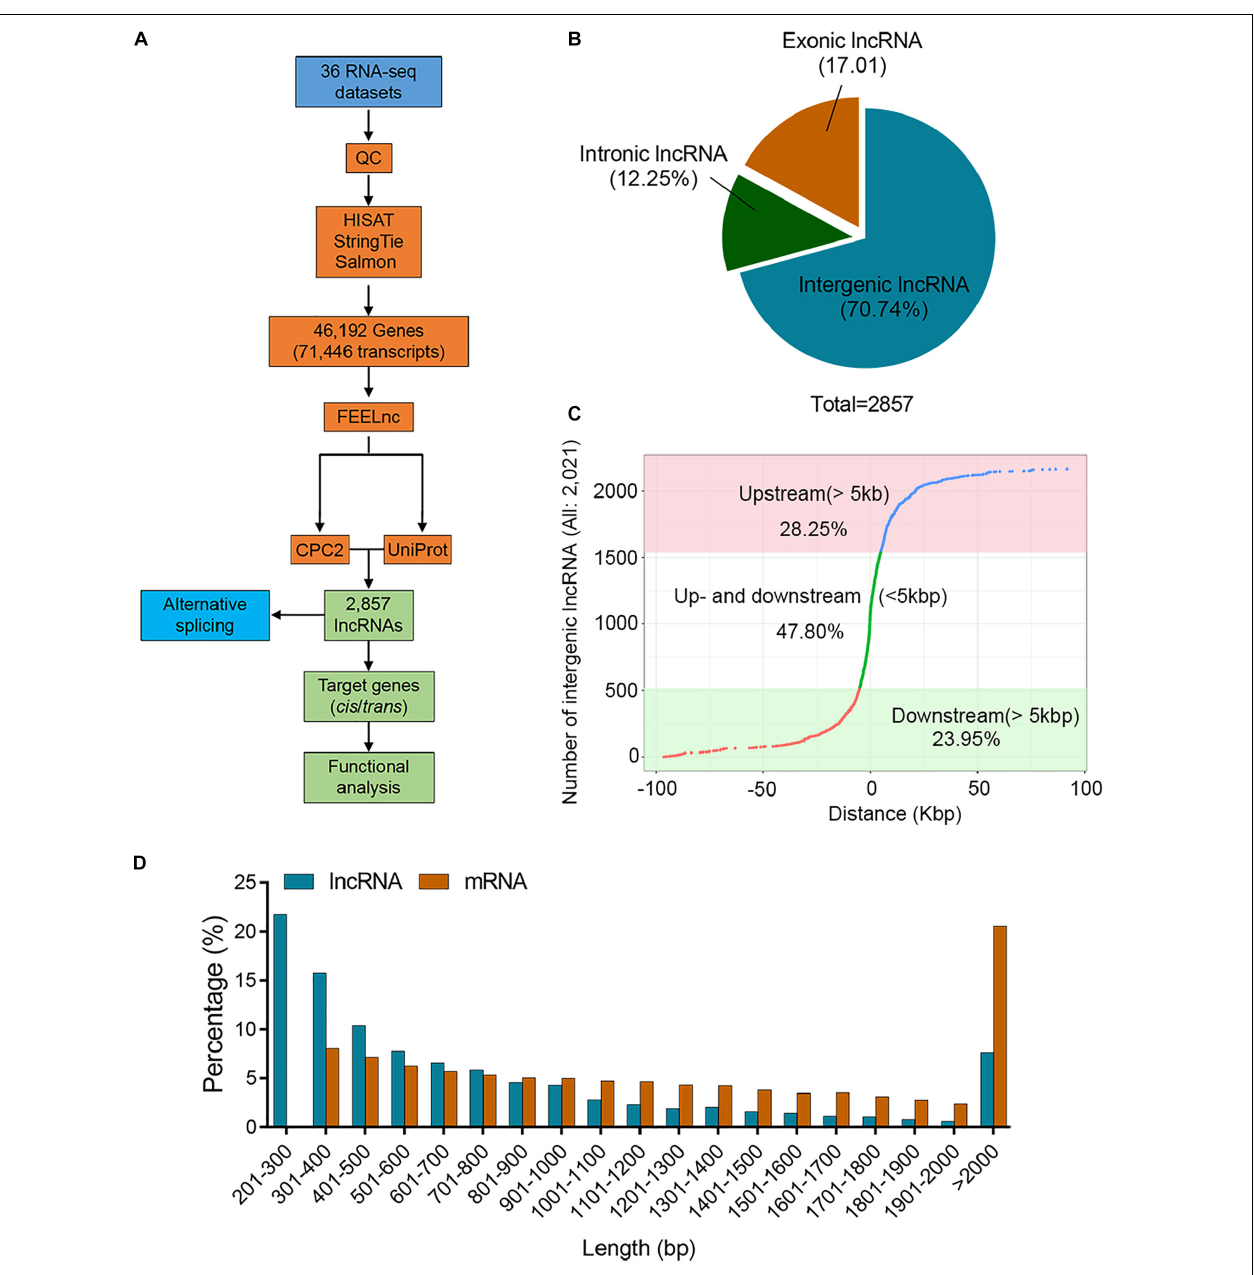
FIGURE 1 | Identification of potato lncRNAs. (A) Pipeline for the identification of lncRNAs in the potato. (B) Proportion of lncRNAs located within 5 kb (upstream or downstream) or further than 5 kb from the nearest protein-coding genes. (C) Distribution of lincRNAs located upstream or downstream > 5 kb and < 5 kb. The X -axis represents the distance between the lncRNA and the nearest coding gene on the chromosome. The positive number represents that the lncRNA is located upstream of the gene, and a negative number represents downstream of the gene. The lncRNA with zero distance from the nearest gene belongs to intronic or exonic lncRNA. (D) Histogram showing the distribution of lncRNA and mRNA